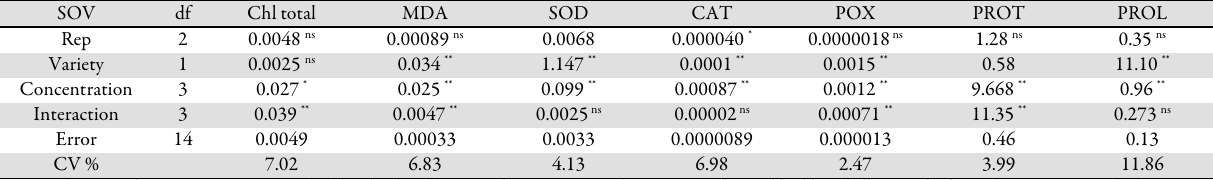
Table 3. Analysis of variance on total Chl, MDA, SOD, CAT, POX, protein and proline of canola genotypes treated by SA in third day SOV